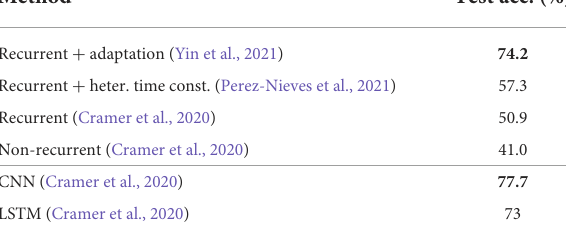
TABLE 3 State-of-the-art on the SSC dataset.